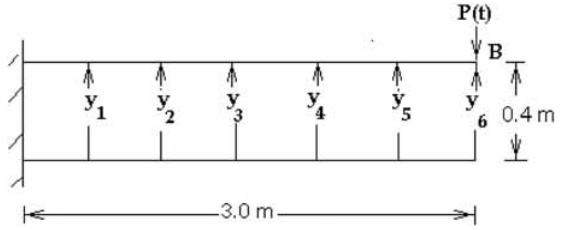
Fig. 2. Cantilever with B-spline boundary (A-B), geometry, boundary conditions, loading and prescribed variables.